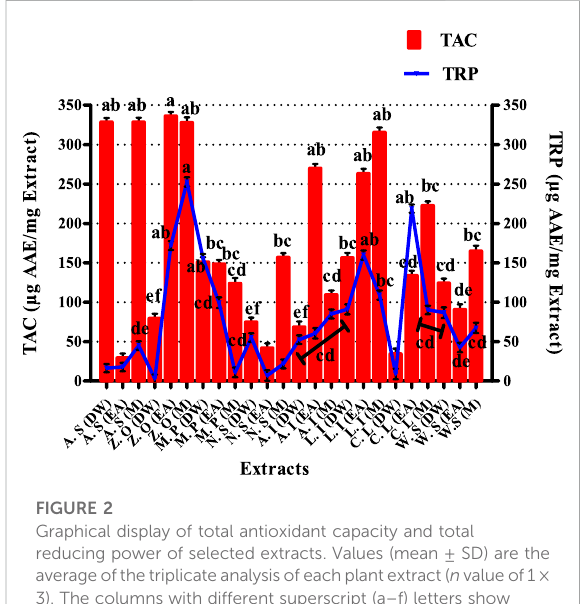
FIGURE 3 Graphical presentation of total phenolic (TPC) and total fl avonoid content (TFC). Values (mean ± SD) are average of triplicate analysis of each plant extract ( n value of 1 × 3). The columns with different superscript (a – e) letters show signi fi cantly ( p < 0.05) different means. A. S, Allium sativum ; Z. O, Zingiber of fi cinale ; M. P, Mentha piperita ; N. S, Nigella sativa ; L. I, Lawsonia inermis; C. L, Curcuma longa ; W. S, Withania somnifera ; EA,ethylacetateextract;DW,distilledwaterextract;M,methanolic